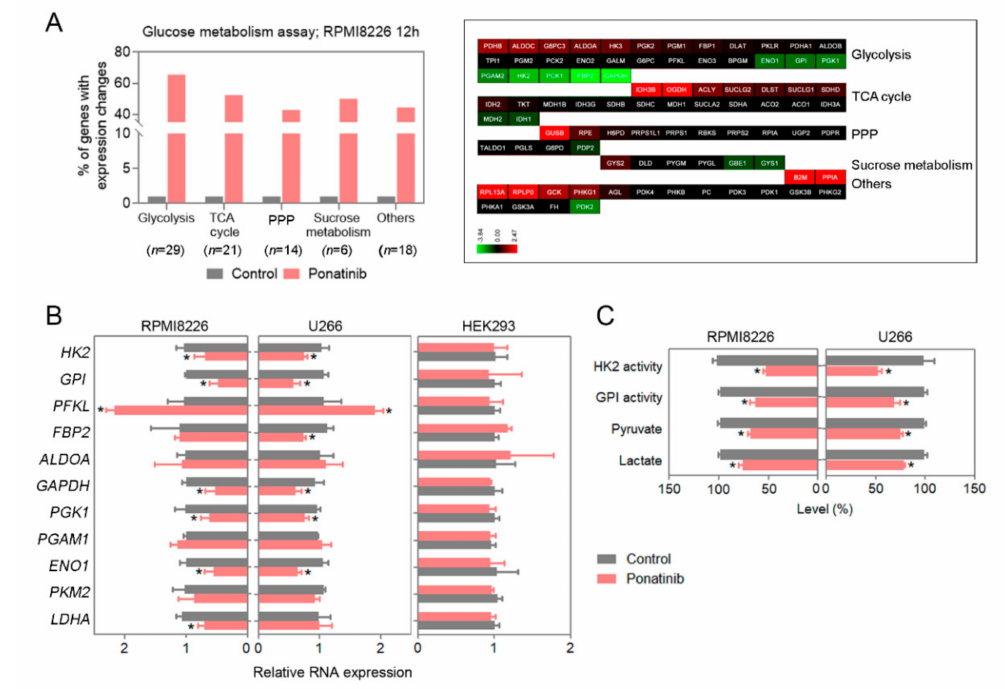
Figure 2. Ponatinib inhibits the glycolysis pathway in multiple-myeloma cells. ( A ) Glucose metabolism array was performed on RPMI8226 cells, using Bioneer gene-expression array plates. Cells were exposed to ponatinib (1 µ M) for 12 h, and total mRNA was extracted. The gene expression was analyzed by using qPCR. The histogram represents the ‘% changes’ in gene expression for differ- ent glucose metabolism pathways. ( B , C ) Ponatinib and vehicle control, dimethylsulfoxide (DMSO), treatment were for 12 h. ( B ) Glycolytic gene-expression changes were quantified by using qPCR. ( C ) HK2 and GPI activity and pyruvate and lactate production were examined by using specific assay kits. Data are presented as mean ± SEM; t -test: * p <